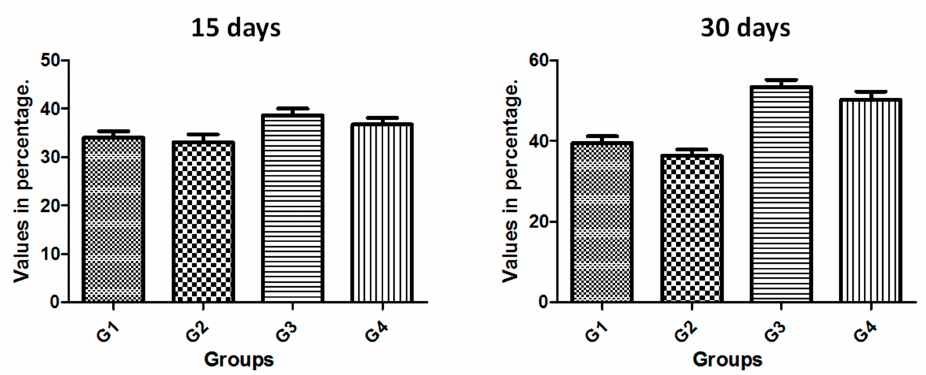
Figure 12. Bar graph of the BIC% mean and standard deviation in the two times proposed.